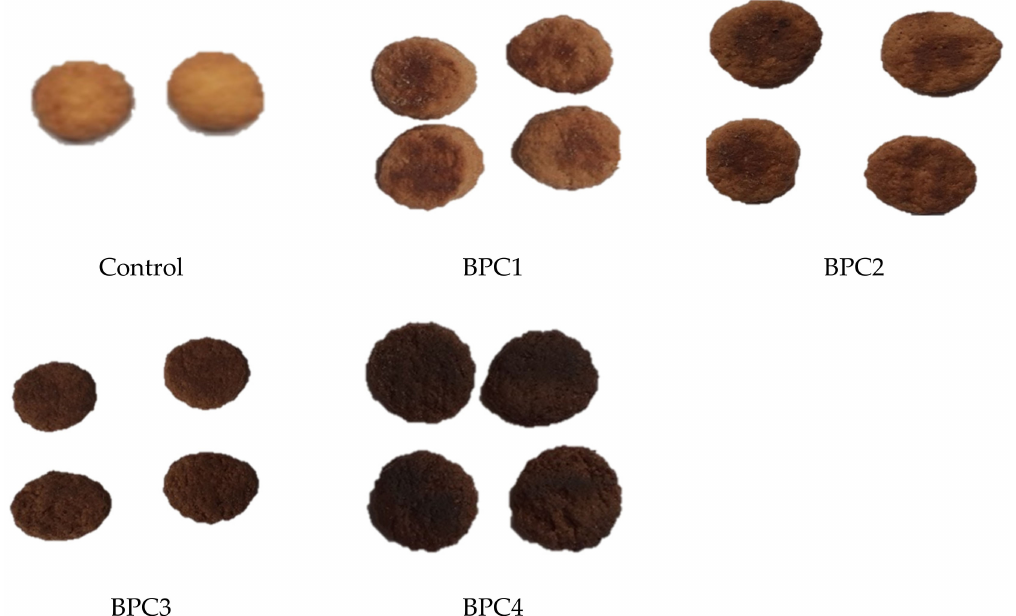
Figure 1. Biscuits formulated using different levels of wheat flour replacement with P. curatellifonia fruit peel flour. Control (100% wheat biscuit), BPC1 (5%), BPC2 (10%), BPC3 (15%) and BPC4 (20%) P. curatellifolia peel